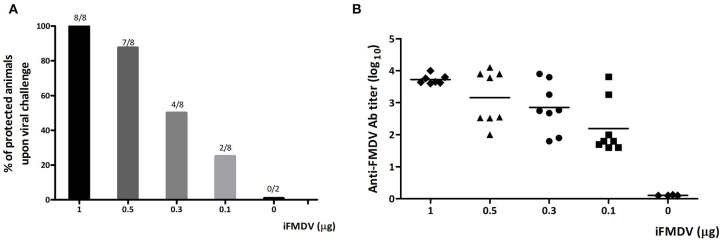
Selection of iFMDV dose for vaccination of BALB/c mice. Groups of mice (n = 8) were vaccinated with 1, 0.5, 0.3, or 0.1 μg of iFMDV in PBS and challenged with infective virus after 21 dpv. (A) Percentages of protected animals on viral challenge. Group 0 corresponds to animals inoculated with PBS. Animals were considered protected if viremia was absent at 24 h post challenge. Protection percentages were calculated as 100× (number of vaccinated animals without viremia/number of vaccinated animals). (B) Antibodies against FMDV elicited by vaccination with different amounts of iFMDV measured by ELISA at 21 dpv.